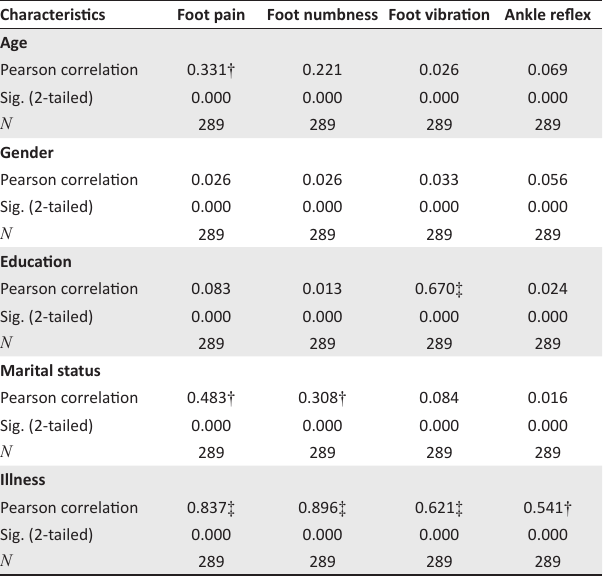
TABLE 3: Relationship between demographic characteristics ( n = 289) and peripheral neuropathy.